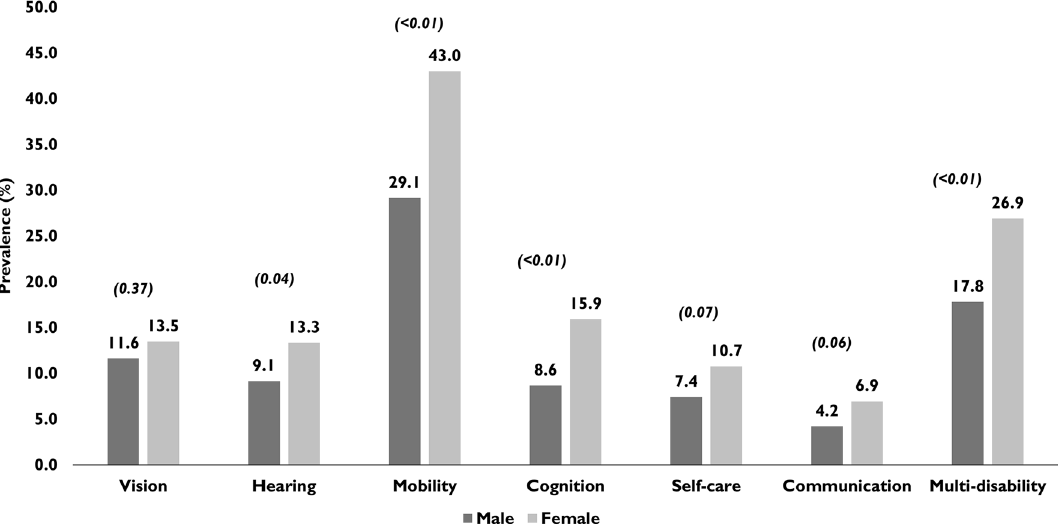
Figure 2. Prevalence of disabilities and multi-disability stratified by gender (n = 1140); statistical significance is shown in parenthesis (Chi squared